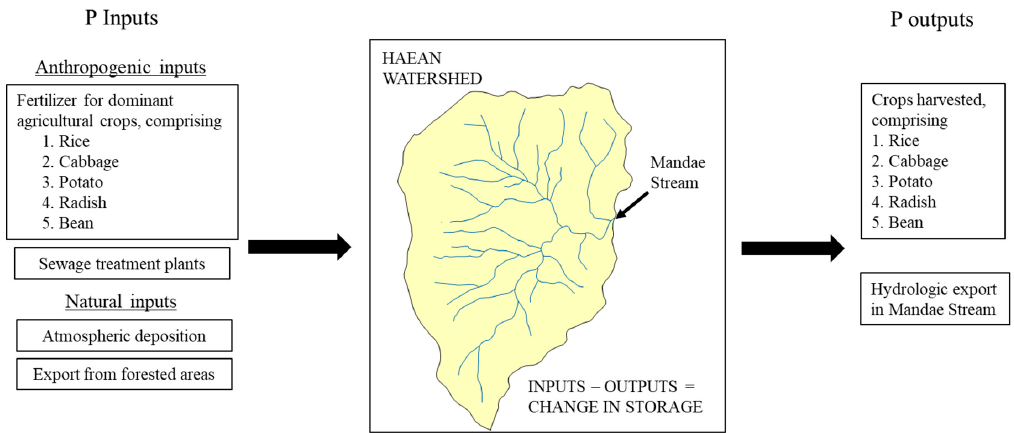
Figure 2. Schematic diagram of P inputs and outputs used to calculate the phosphorus budget for the Haean watershed.